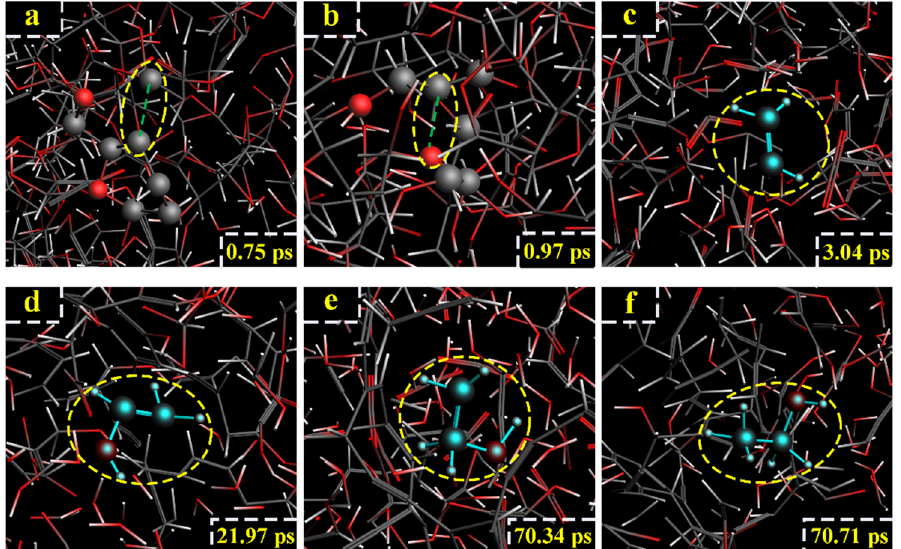
Figure 11. Path I for the production of ethanol. ( a – f ) are the procedure of cellobiose to produce ethanol at 2600 K.